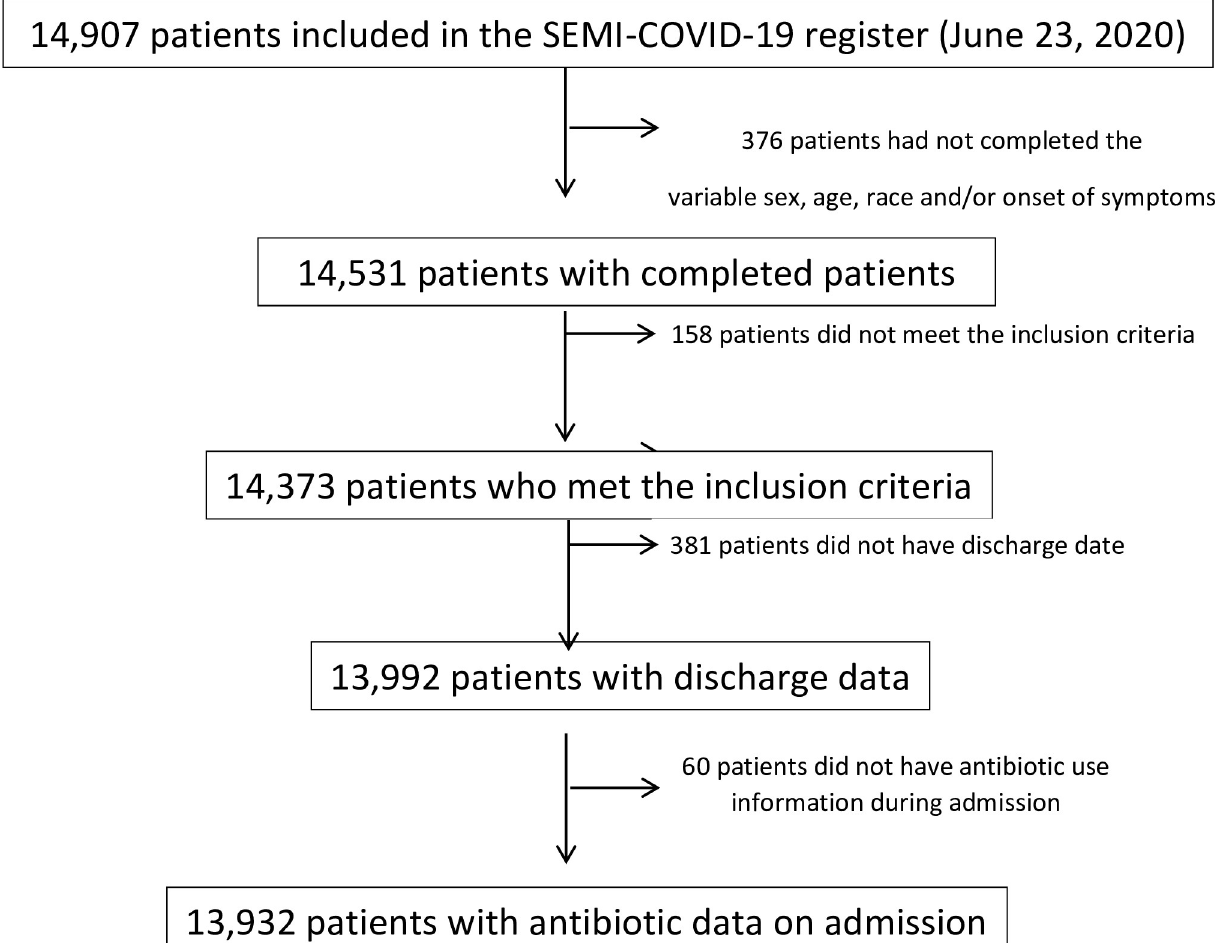
Fig 1. Patient flowchart. (13.4%), linezolid (2.2%), glycopeptides (1.6%), co-trimoxazole (0.6%), and tetracyclines (0.6%). The rest of the antibiotics accounted for less than 0.3% of patients each. Criteria for antibiotic prescription Of all patients, 52.4% met at least one criterion for the use of antibiotics. The most common criteria were unilateral alveolar infiltrate (17.5%), cough with purulent expectoration (15.5%), negative SARS-CoV-2 PCR (11.9%), respiratory bacterial co-infection and/or superinfection (10.9%), sepsis (6.2%), procalcitonin equal to or greater than 0.5 ng/mL (5.7%), significant pleural effusion (3.0%), shock (4.5%), and positive pneumococcal and/or legionella urine antigens (1.5%). The presence of superinfections other than respiratory superinfections was rare, including venous catheter-related bacteremia (0.8%), urinary tract infection (0.8%), abdominal infection (0.3%), skin and soft tissue infection (0.1%), other infections (0.1%). Table 1 summarizes the criteria for antibiotic prescription. Inappropriate antibiotic prescription In total, non-macrolide antibiotics were not prescribed in 3,047 patients (21.6%), whereas they were appropriately prescribed in 6,116 patients (43.9%), and inappropriately prescribed in